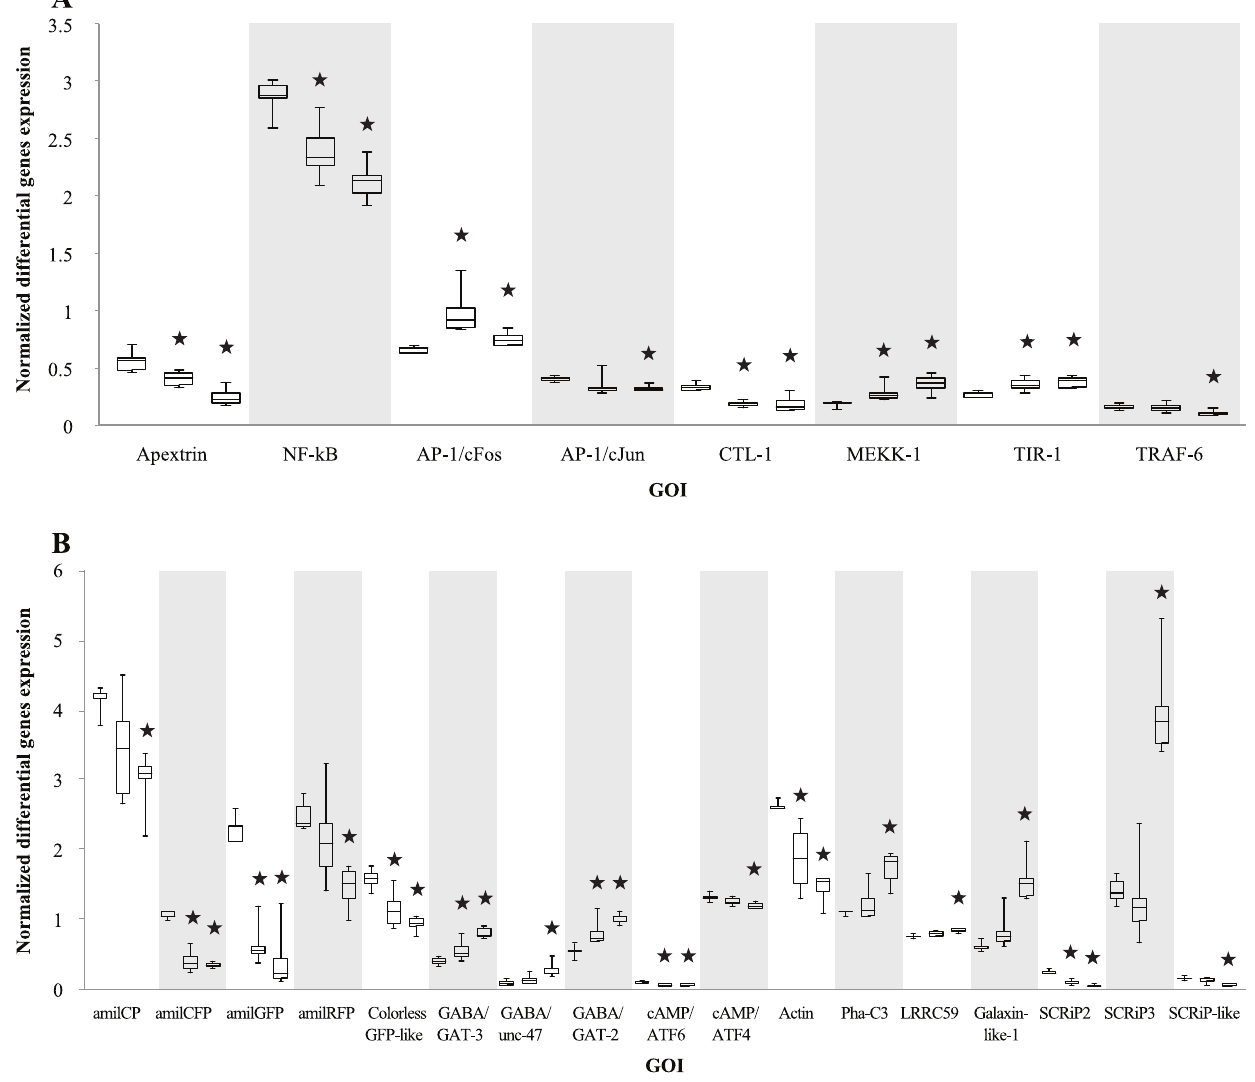
Figure 2. Expression levels of GOI following exposure of A.millepora larvae to the bacterial TBP-containing extract. (A) Assay 1 and (B) Assay 2. The left box plot for each gene represents swimming larvae exposed to control (no extract), the middle and right box plots represent swimming larvae exposed to low and high concentration treatments, respectively. The box plots denote GOI that presented significant differences in expression ( p , 0.05 , Kruskal–Wallis followed by multiple comparison of mean ranks) from the control in one or both of the treatments. The gene expression levels were normalized against geomean (Excel 7) calculated from the most stable genes. An asterisk ( w ) highlights those GOI that were significantly different from the